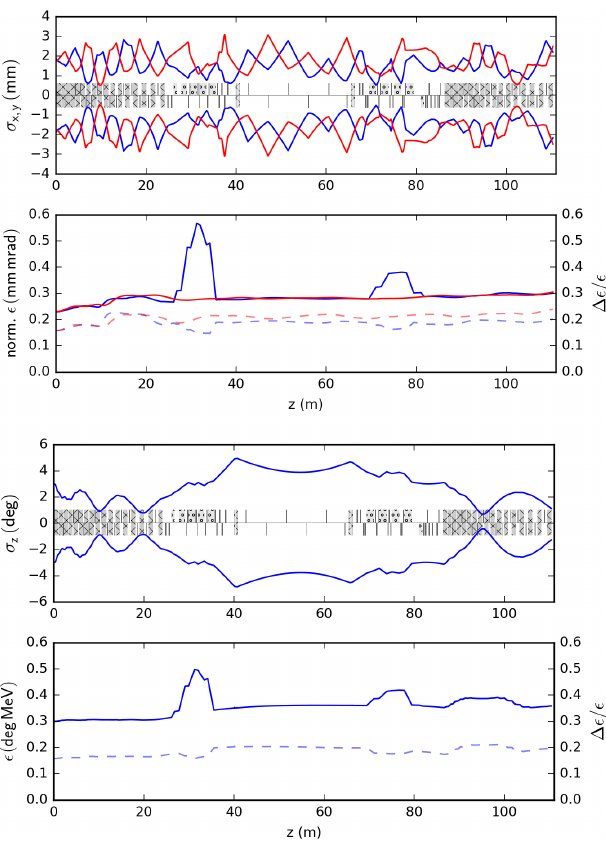
FIG. 21. Maximum transverse radius (blue) and longitudinal (red) phase for 20 mA case with waterbag (top) and Gaussian (bottom) initial